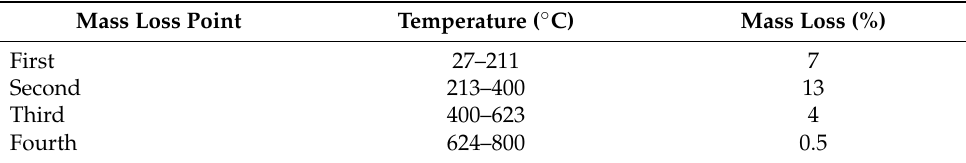
Table 2. Temperature points where mass losses occurred against the resistance of synthesized AC- AuNPs to heat